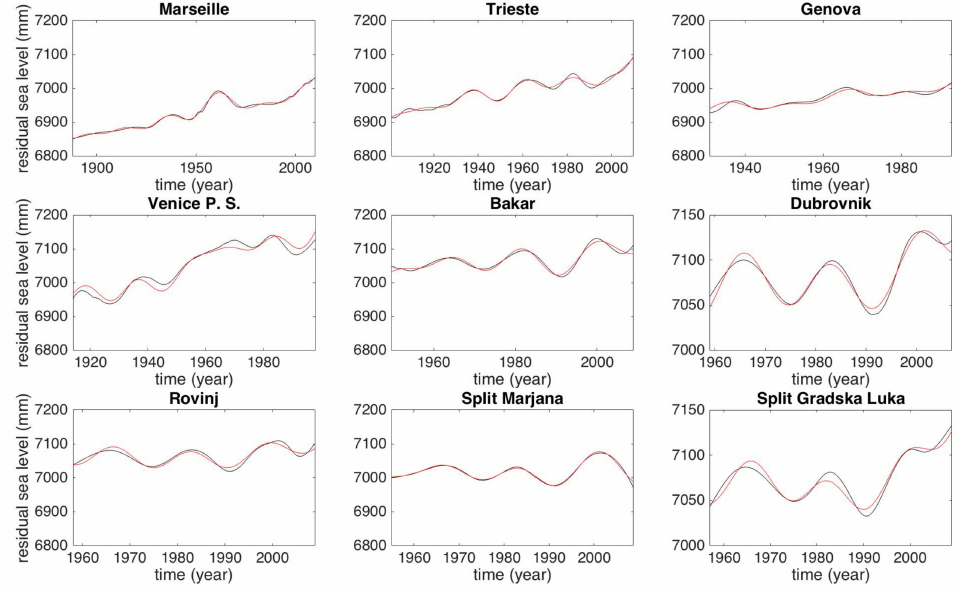
Figure 3. Function L LT ( t ) (black line), obtained by summing up IMFs at timescales > 15 years and the residue, and the best-fit function L M ( t ) (red line) described by Equation